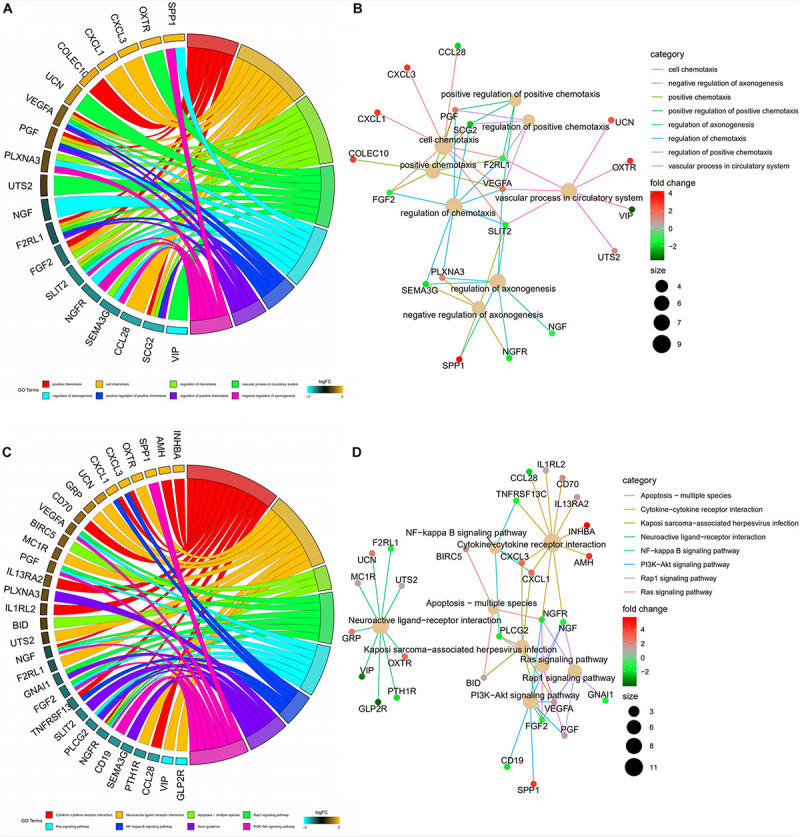
Functional enrichment analysis of prognostic immune-related DEGs. (A) The top 8 significant biological process terms of the GO analysis. Genes and their logFC expression in each enriched gene ontology term are shown. (B) Construction of the BP terms-genes network. Degrees were visualized by the size of the nodes, while the interaction between BP terms and genes were represented by the edge. (C) Top 8 enriched KEGG pathways for the prognostic immune-related genes. (D) Construction of the enrichment pathways-genes network.